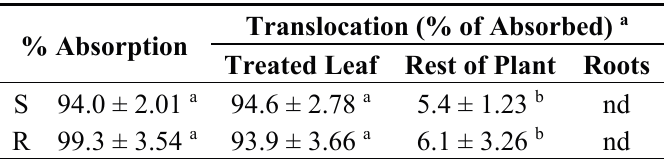
Figure 2. Phosphor images showing movement of [ 14 C] DM in P. minor susceptible (S) and resistant (R) biotypes. Images were recorded 72 h after treatment; the intensity of red coloration indicates higher concentrations of DM. Table 2. Radiolabel translocation from the treated leaf in resistant and susceptible biotypes of P. minor 72 HAT with [ 14 C]Diclofop-Methyl(DM).